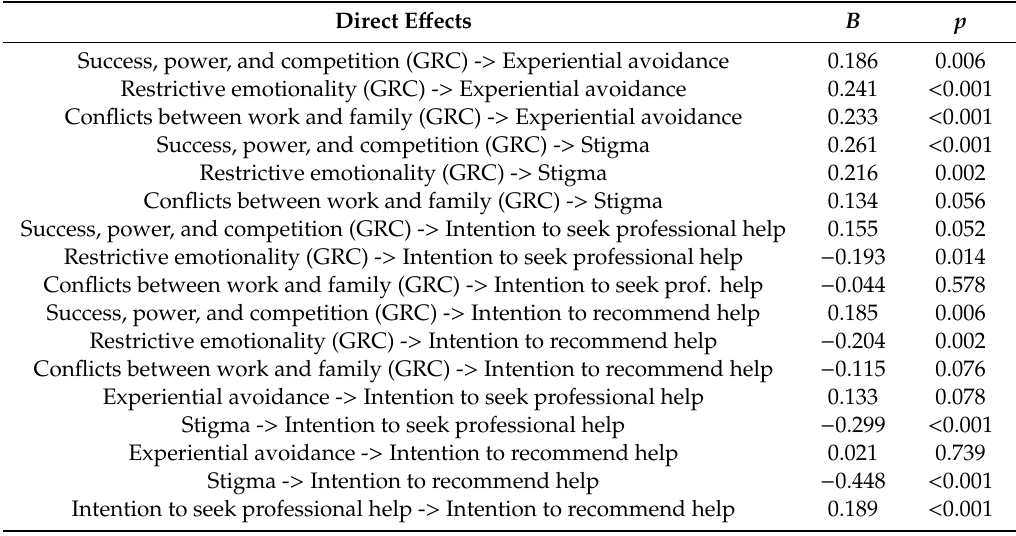
Table 4. Path coe ffi cients of the final model (direct e ff